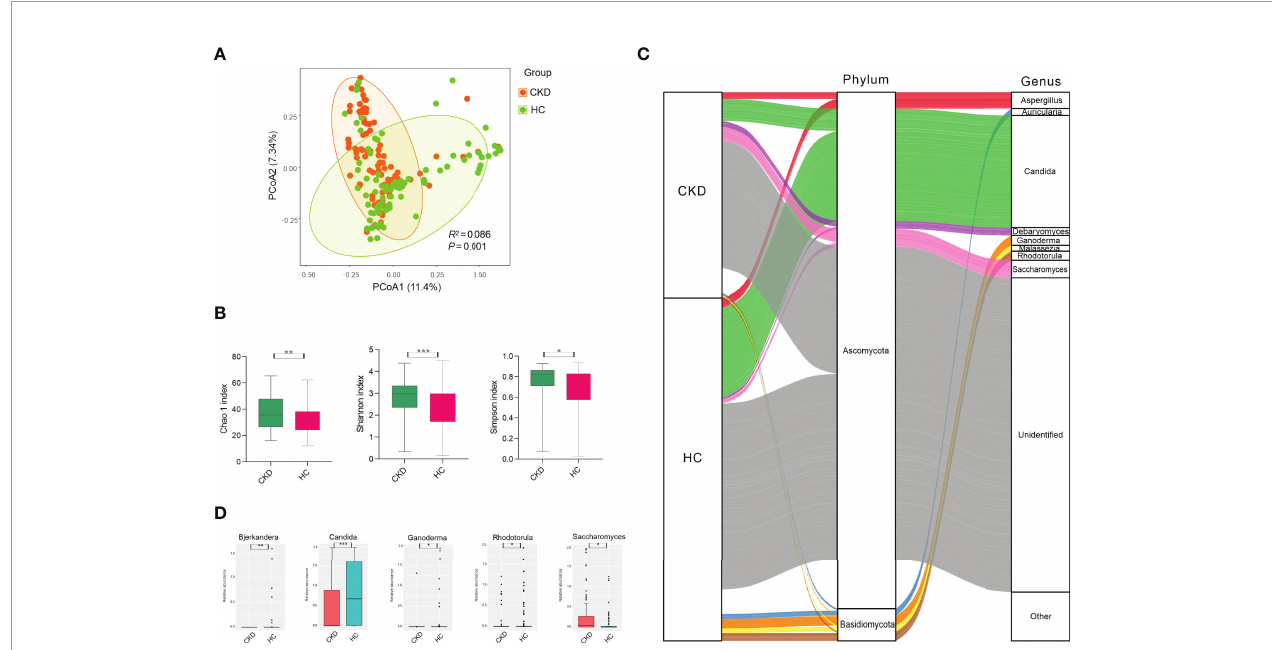
FIGURE 1 | Microbial community, diversity, composition, and differed genera in the cohorts of CKD and HC. (A) PCoA based on Bray – Curtis distances at the OTU level showed different microbial compositions between groups of CKD patients and HCs ( P < 0.05). Permutational multivariate analysis of variance (PERMANOVA) was performed for statistical comparisons of samples in the two cohorts. P -value was adjusted by the Benjamini – Hochberg FDR. (B) Bacterial richness and diversity measured by Chao1, Shannon, and Simpson were calculated at the microbial OTU level. The CKD patients had signi fi cantly higher levels of bacterial richness and diversity. The Wilcoxon rank-sum test was performed and adjusted by the Benjamini – Hochberg FDR. ** indicates P < 0.01. (C) Microbial pro fi le at the phylum and genus levels. Sankey plot representing the overall gut mycobiome composition and corresponding abundance area for CKD patients and HCs. The taxonomic classi fi cation levels of phylum and genus are displayed. The top ten most abundant genera and their af fi liated phyla are shown in the Sankey plot. (D) Microbial genera that were differentially abundant between CKD patients and HCs. Only the genera with above 1% are displayed. P -value was calculated using the Wilcoxon rank-sum test and adjusted by the Benjamini and Hochberg FDR. *, **, and *** indicate P < 0.05, P < 0.01, and P < 0.001,